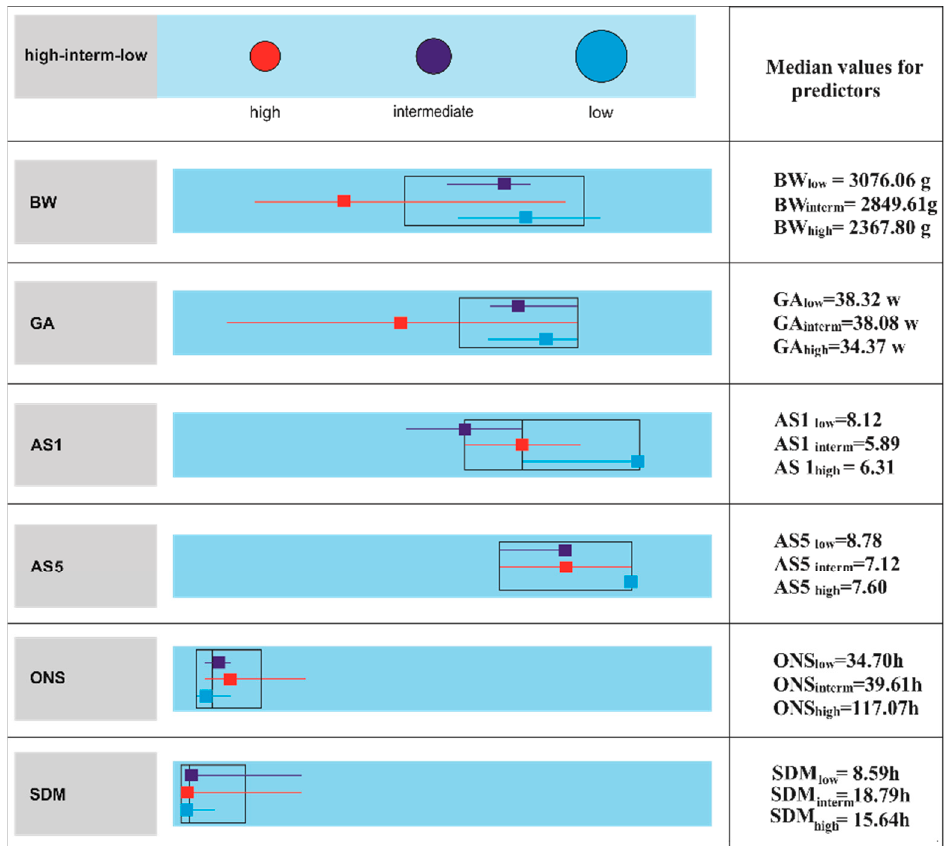
Figure 2. Cluster analysis for high-risk, intermediate and low-risk categories based on BW, GA, AS1, AS5, ONS, SDM. Median values for the predictors highlight the tendencies for each cluster. We recorded a fair silhouette measure of cohesion and separation for the three clusters (high, intermediate and low risk cases).